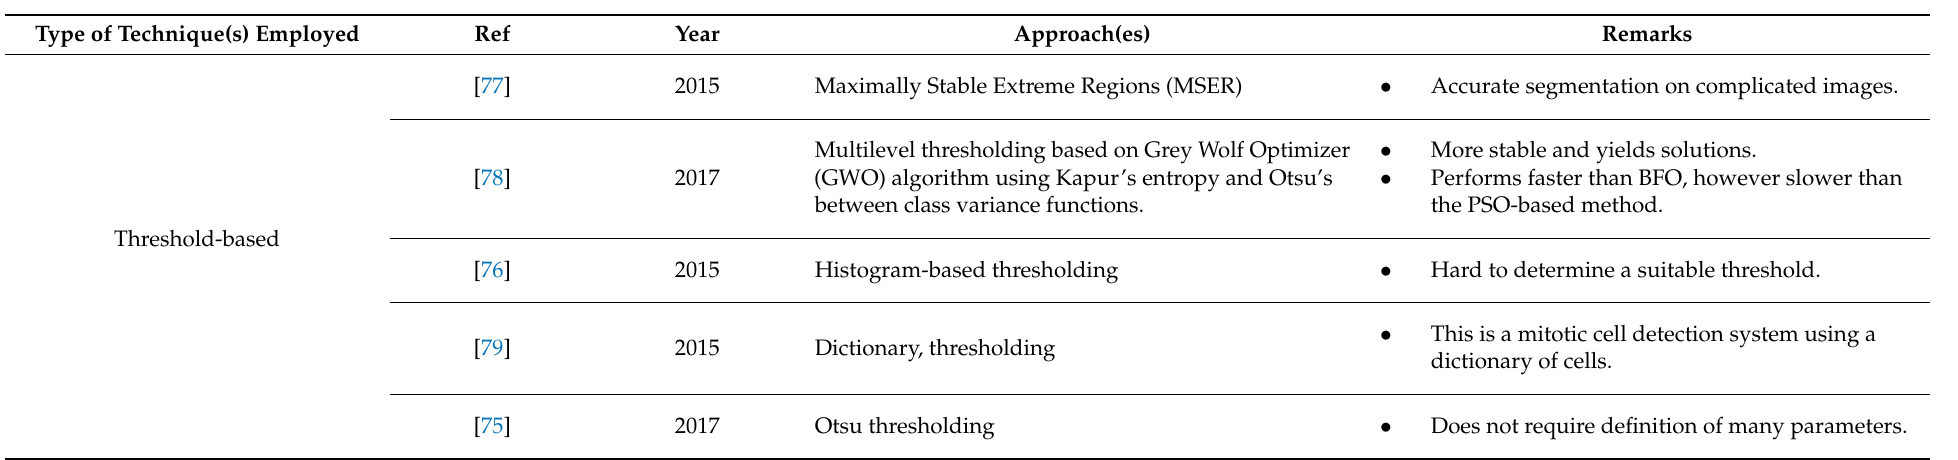
Type of Technique(s) Employed